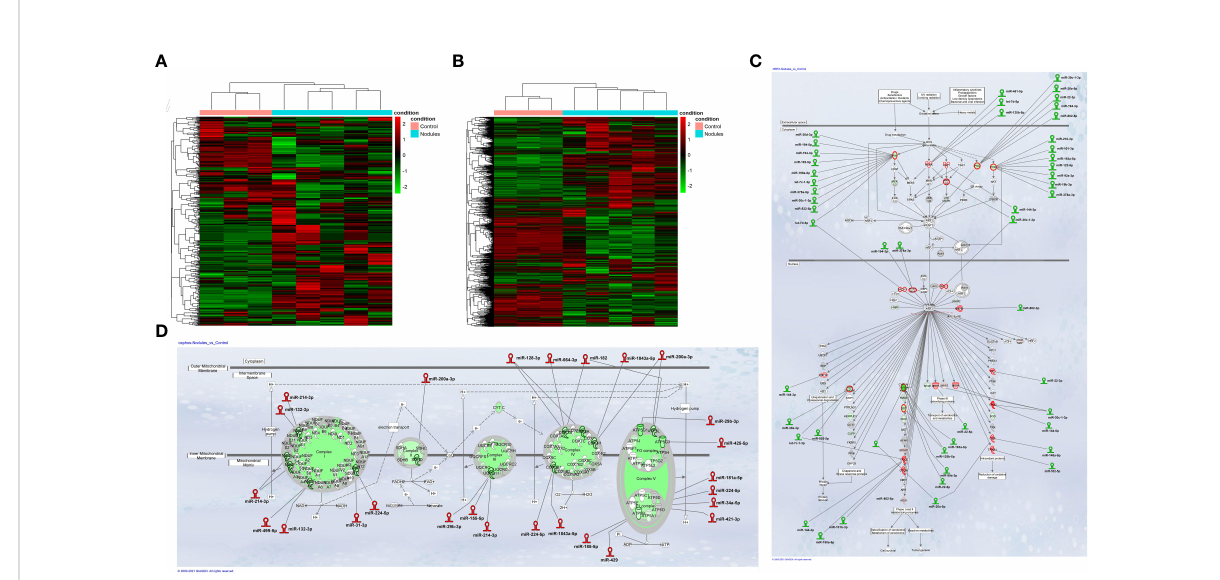
FIGURE 1 (A) Hierarchical clustering of miRNAs in preneoplastic lesions (nodules), and control samples. Each row represents the expression of a gene and each column a sample. Red and green colors represent higher or lower mRNA expression levels (median-centered), respectively; (B) Hierarchical clustering of genes in preneoplastic lesions (nodules), and control samples. Each row represents the expression of a gene and each column a sample. Red and green colors represent higher or lower mRNA expression levels (median-centered), respectively; (C) IPA analysis of the Nrf2 oxidative stress response pathway and; (D) the Oxidative Phosphorylation pathway (OXPHOS) in early preneoplastic nodules. Hairpin loop structures represent miRNAs. (Red: Up-regulated, Green: Down-regulated). Edges connect miRNAs and putative target genes predicted by TargetScan/TarBase/miRecords and Ingenuity Expert